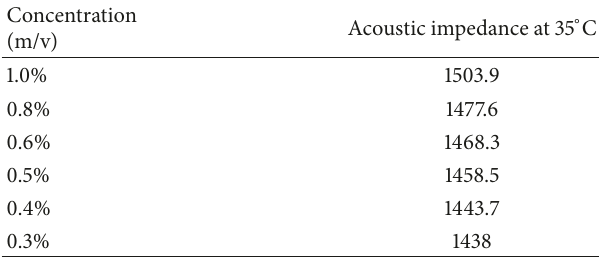
Table 3: Ultrasonic velocity (m/s) of polyvinyl alcohol (PVA) at different concentration at 1MHz frequency.